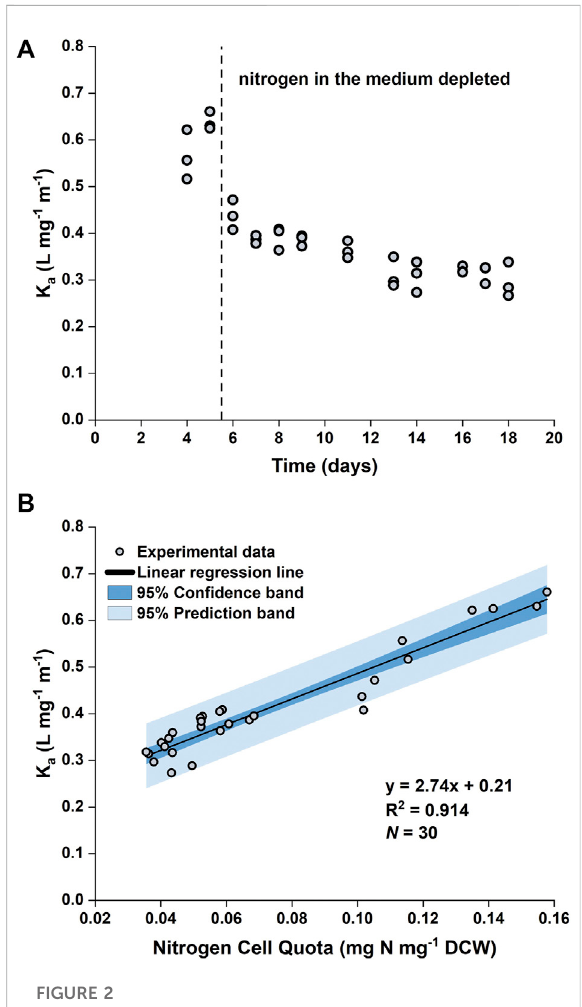
FIGURE 2 Time evolution of biomass absorption coef fi cient ( K a ) (A) and the relationship between K a and the nitrogen cell quota (B) in batch cultures of P. tricornutum under nitrogen-limited conditions. The batch cultures were grown in 5 L fl at-panel PBRs with 4 × f /2 medium. Datapoints were pooled from three biologically independent